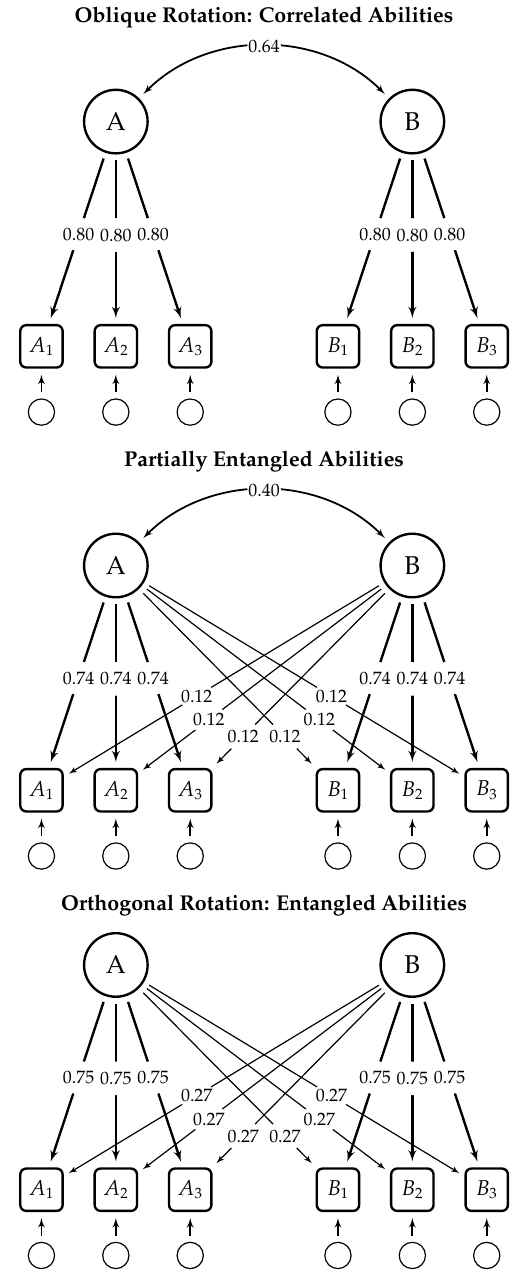
Figure 3. Different rotations imply different causal